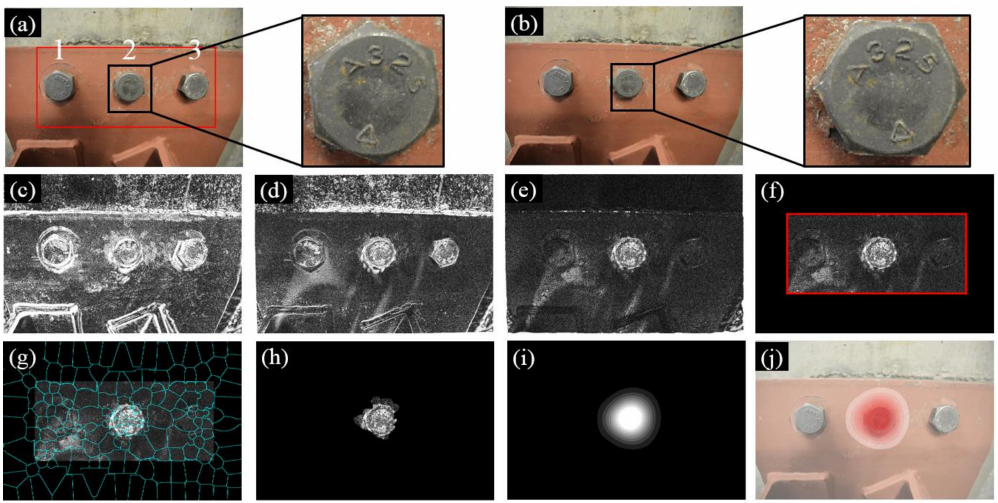
Figure 8. Experimental results of Test 1: ( a ) Image 1 taken at the first inspection period; ( b ) Image 2 taken at the second inspection period; ( c ) initial errors between Image 1 and 2; ( d ) errors after feature-based image registration; ( e ) errors after intensity-based image registration; ( f ) windowing applied to the registration errors; ( g ) registration errors segmented into superpixels; ( h ) feature enhancement; ( i ) Gaussian filtering; and ( j ) result implementation. The brightness of Figure 8c–h is enhanced for demonstration purposes.